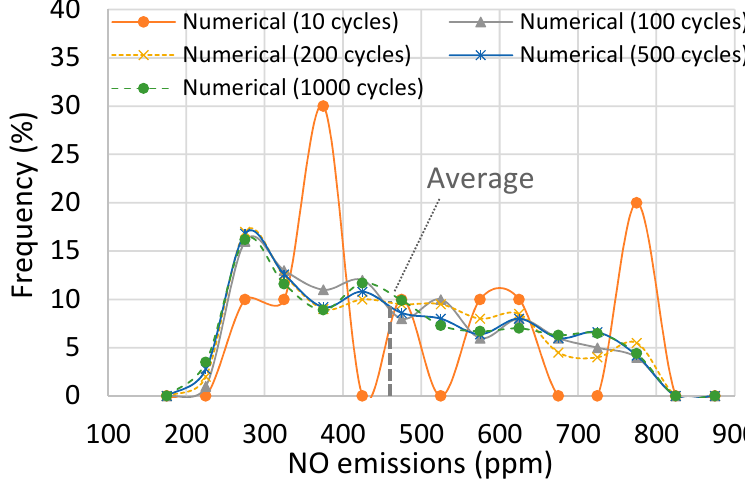
Figure 8. Frequency of NO emissions for a different number of cycles.